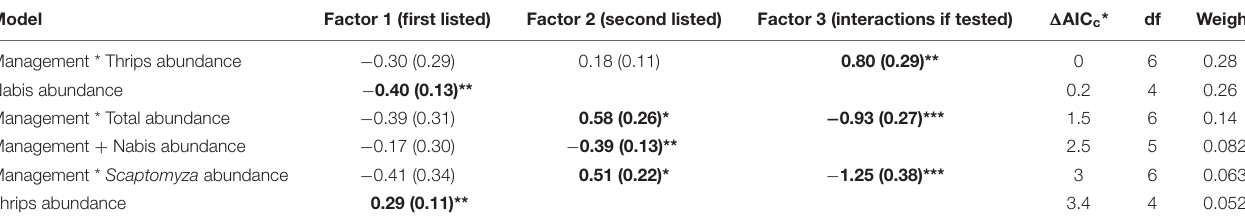
TABLE 1 | Model selection results for arthropod community and farm management (conventional = 0, organic = 1) that influence the probability of detecting thrips DNA in Geocoris guts.